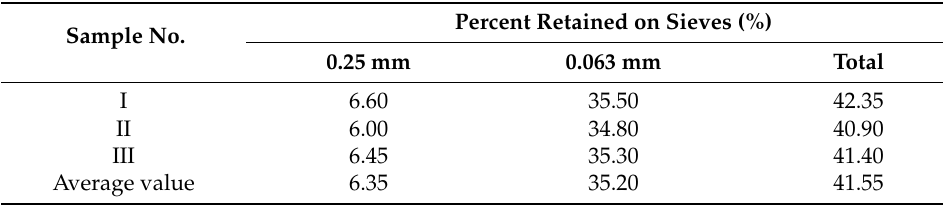
Table 3. Particle size analysis of a slag-ash mixture.